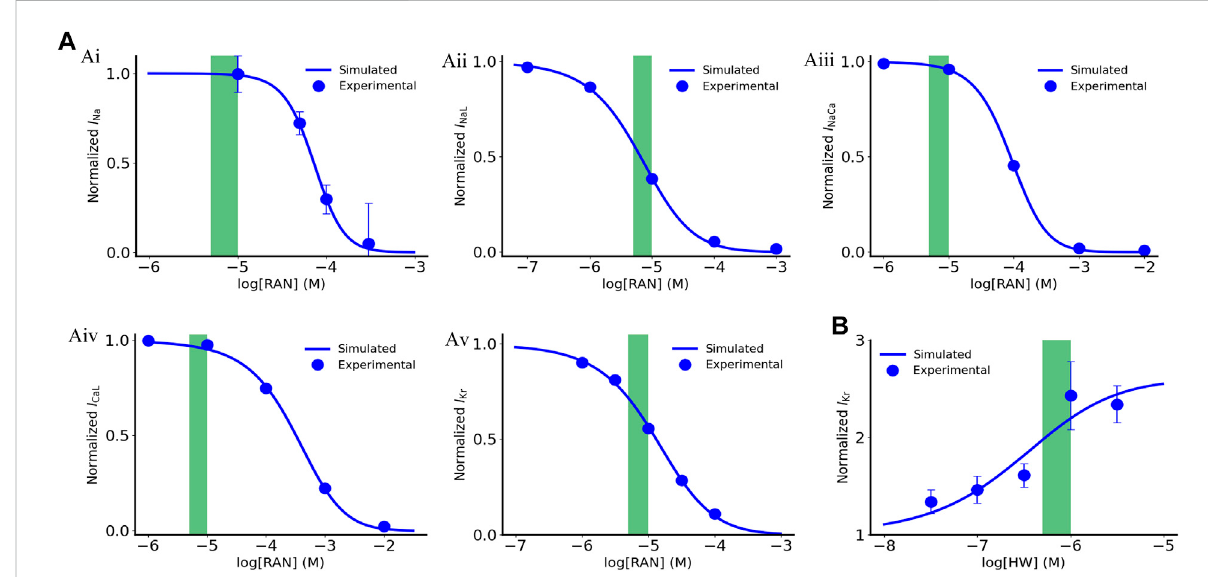
FIGURE 1 Dose dependent effects of ranolazine and HW-0168 on ionic currents. (A) Effects of ranolazine on I Na , I NaL , I NaCa , I CaL and I Kr . (B) Effects of HW- 0168 on I Kr . Green boxes indicate therapeutic ranges of ranolazine (5 – 10 μ M) and HW-0168 (0.5 – 1 μ